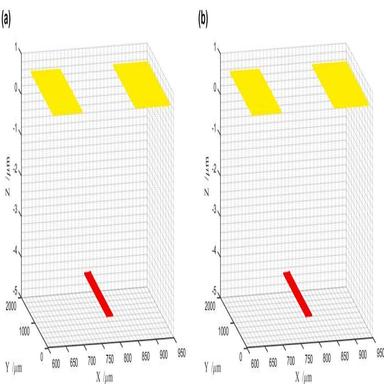
Data visualization of the evaluated planes in Experiment 2: (a) The evaluated planes; (b) The results after levelling the upper two yellow planes. (For interpretation of the references to color in this figure legend, the reader is referred to the Web version of this article.)